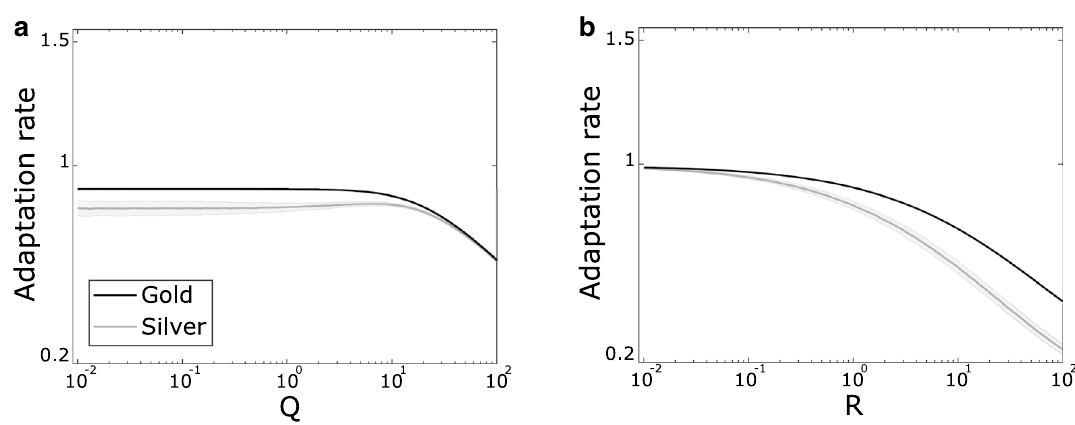
Figure 4. Silver adaptation rates approximate gold standard adaptation rates. Simulated data for changing control noise ( a ) and sensory noise ( b ). Silver adaptation rates can be calculated from data collected in carefully controlled experiments 4 . Simulation parameters as in Fig.